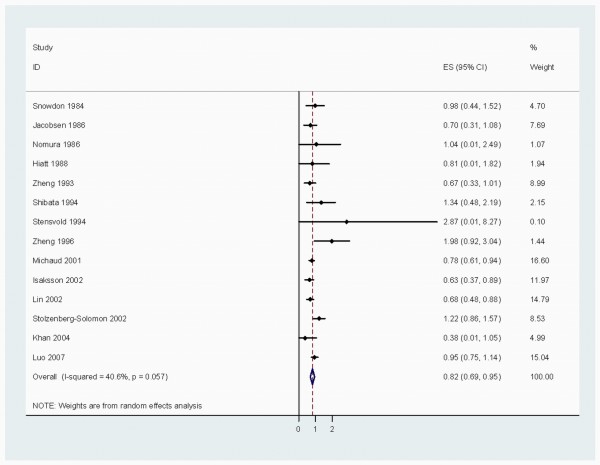
Summary RRs of pancreatic cancer for high coffee drinkers versus non/lowest drinkers from included studies. Squares represent study-specific relative risk estimates (size of the square reflects the study-specific statistical weight, that is, the inverse of the variance); horizontal lines represent 95% CIs; diamonds represent summary relative risk estimates with corresponding 95% CIs.